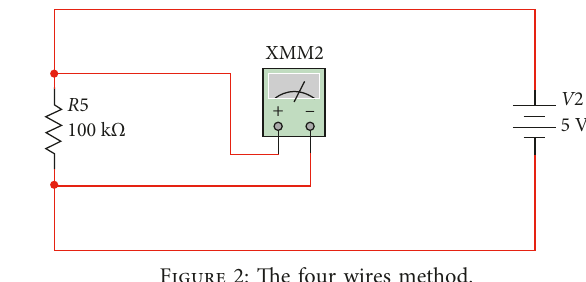
Figure 2: The four wires method.